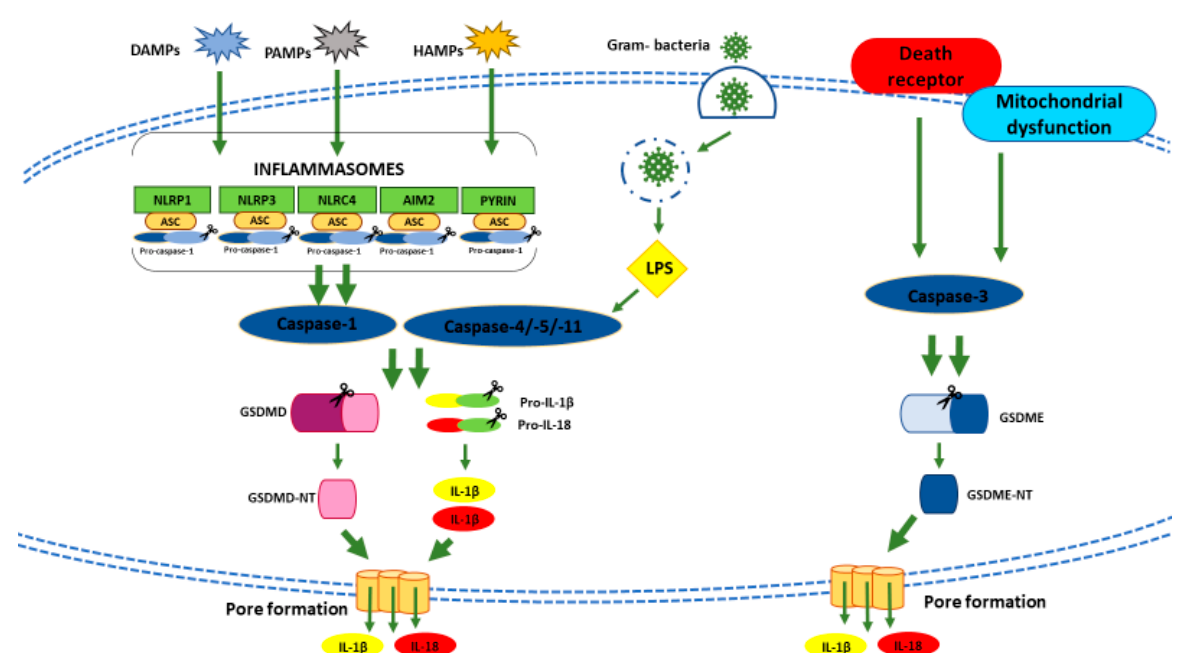
Figure 3. Schematic representation of canonical, non-canonical, and caspase-3-dependent pyroptotic cell death pathway. AIM2: Absent in melanoma 2; ASC: Apoptosis-associated speck-like protein containing a CARD (caspase activation and recruitment domain); DAMPs: Damage-associated molecular patterns; GSDMD: Gasdermin D; GSDMD-NT: N-terminal fragment of GSDMD; GSDME: Gasdermin E; GSDME-NT: N-terminal fragment of GSDME; HAMPs: Homeostasis-altering molecular processes; IL-1 β : Interleukin-1 beta; IL-18: Interleukin-18; LPS: Lypopolisaccaride; NLRC4: NLR (nucleotide- binding oligomerization domain (NOD)-like receptor) family CARD domain-containing protein 4; NLRP3: NLR family pyrin domain-containing 3; NLRP1: NLR family pyrin domain-containing 1; PAMPs: Pathogen-associated molecular